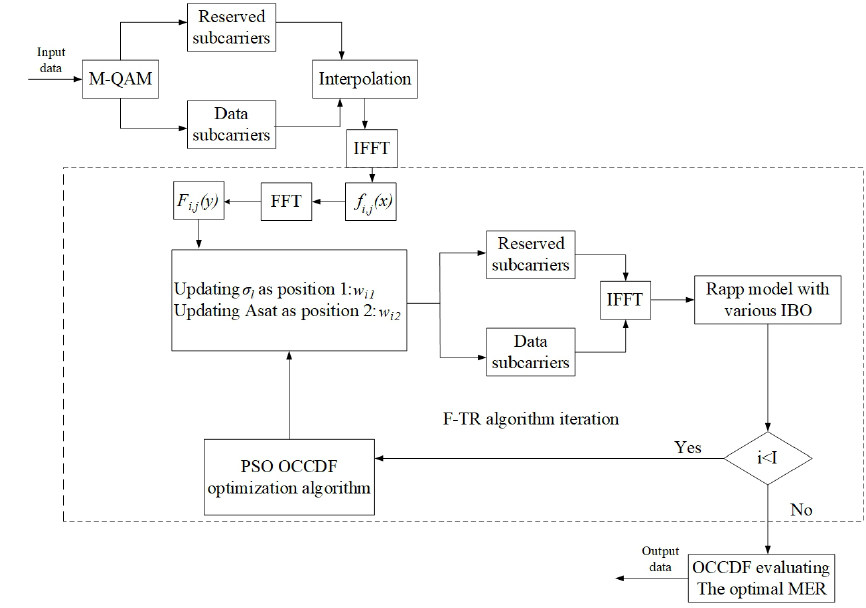
Figure 4. Structure of the FPSO-TR